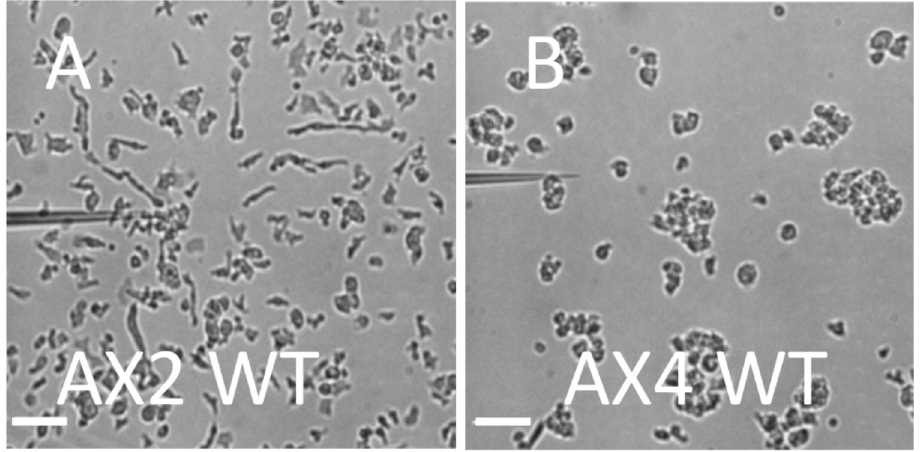
Fig 2. Developed WT cells on a uniform PEG-gel surface. Micrographs of AX2 (A) and AX4 (B) exposed to a gradient of chemoattractant cAMP leaking from a pipette. AX2 cells adhere to the surface and migrate toward the leaky pipette, while the AX4 cells remain in clumps and do not migrate (Scale bar: 50 μm